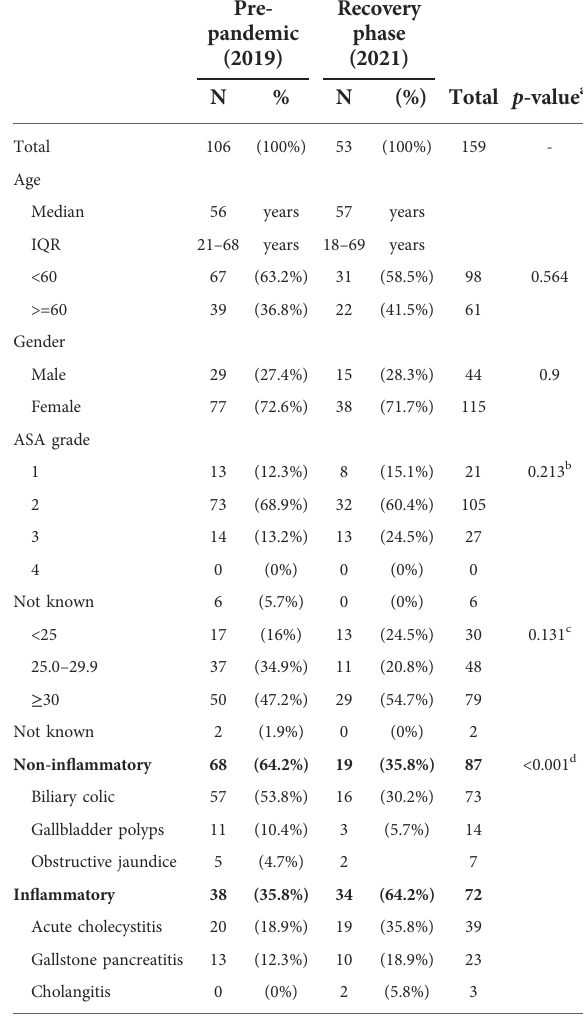
TABLE 1 Patient